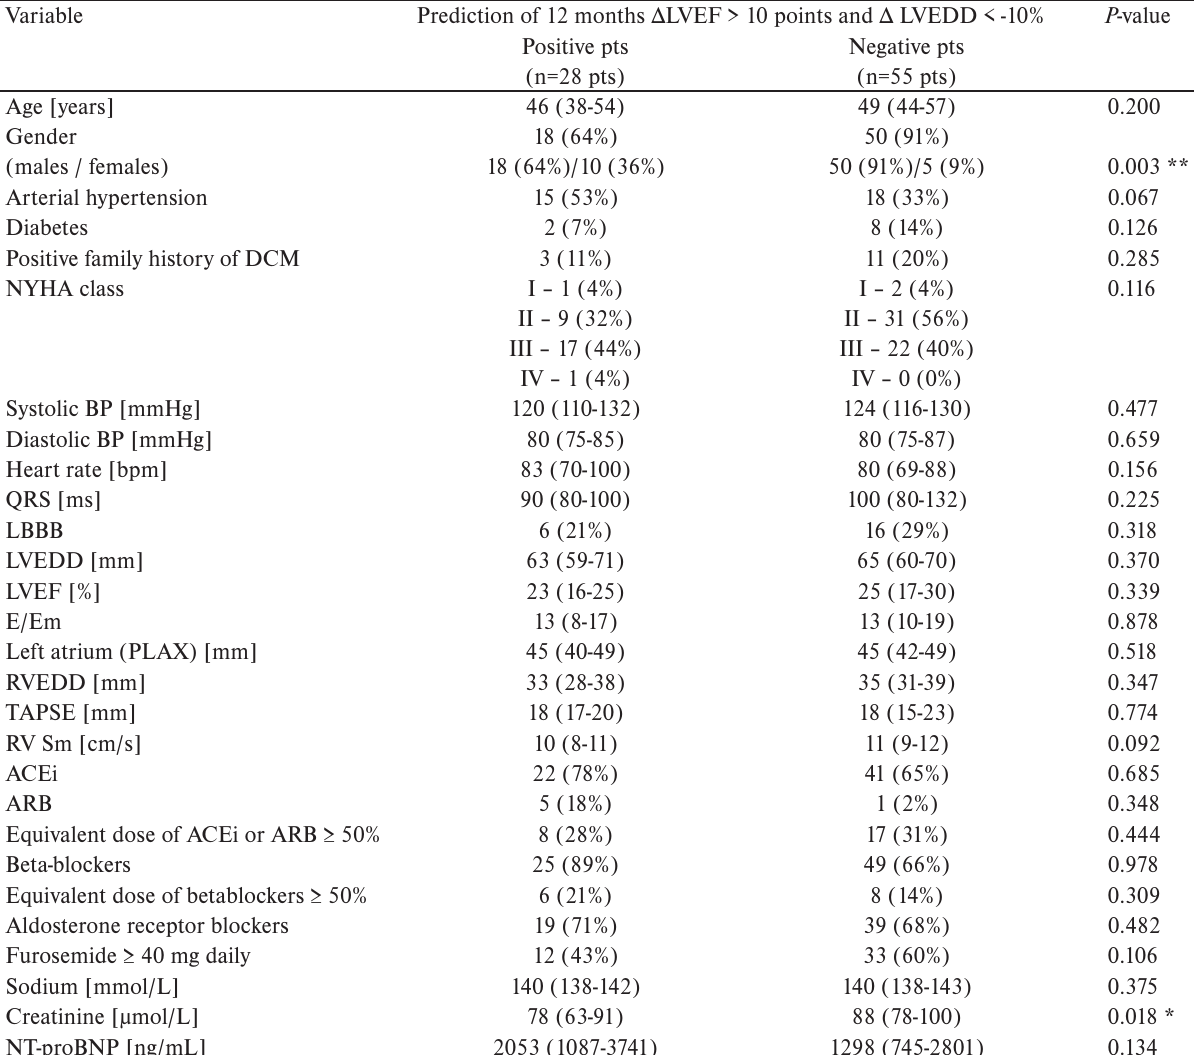
Table 3. Left ventricular reverse remodelling and baseline patient